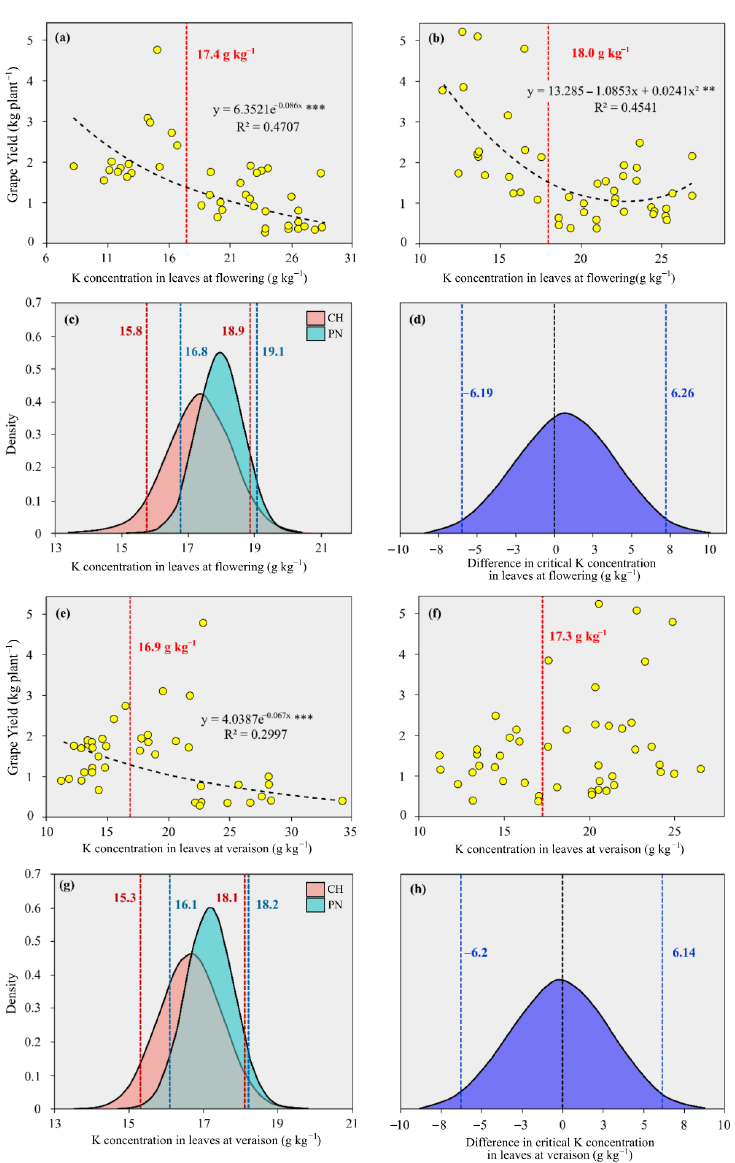
Figure 3. The relation between relative grape yield and K concentration in leaves at flowering ( a , b ); and veraison ( e , f ) in 2016/17, 2017/18 and 2018/19, in ‘Chardonnay’ (CH, ( a , e )) and ‘Pinot Noir’ (PN, ( b , f )), soil fertilized with K. Frequency density of the critical K concentration in the leaves at flowering ( c ) and veraison ( g ). Difference in frequency density of the critical K concentration in the leaves at flowering ( d ) and veraison ( h ), between ‘Chardonnay’ and ‘Pinot Noir’. Vertical dashed red and blue lines represent, respectively, the range of probability of occurrence of the critical level of K, for the cultivars ‘Chardonnay’ and ‘Pinot Noir’ ( a , g ). Vertical dashed blue represent the distribution between the critical difference between cultivars, while the black dashed line refers to zero ( d , h ). Vertical dashed red line refers to the critical level value of K, respectively, at flowering for ‘Chardonnay’ and ‘Pinot Noir’ ( a , b ) and at veraison for ‘Chardonnay’ and ‘Pinot Noir’ ( e , f ). Dashed black line refers to the behavior of equation ( a , b , e ). “**” Significant at 1% ( p < 0.01). “***” Significant at 0.1% ( p <